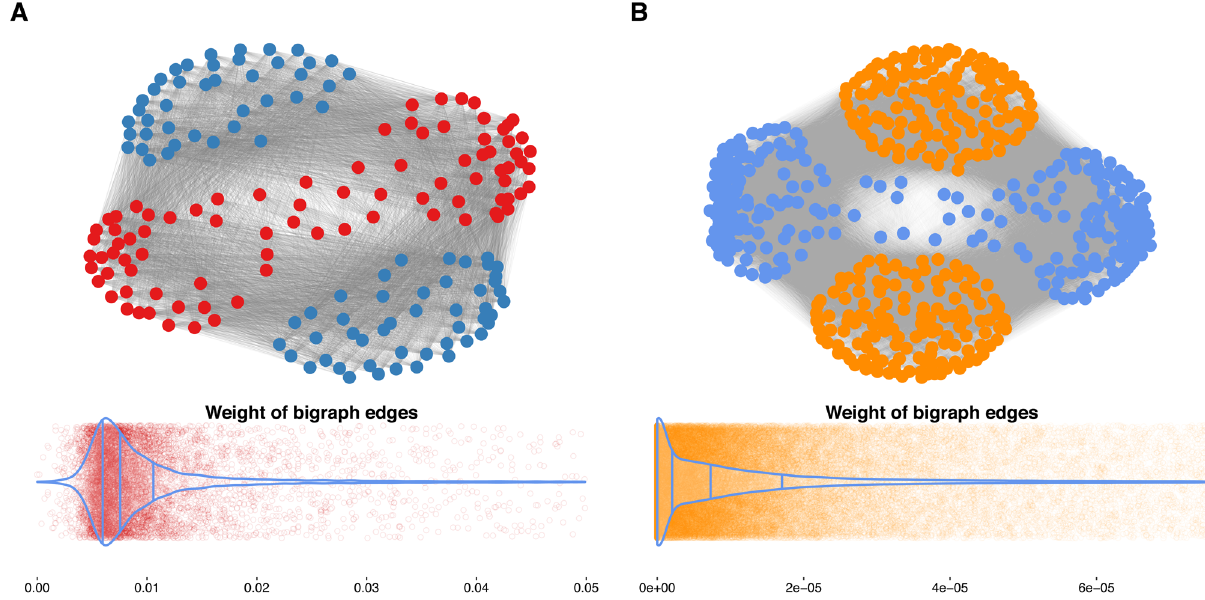
Fig. 3 Bigraphs of cancer datasets. The general overview of the bipartite graphs for the Beat AML ( A ) and GDSC ( B ) datasets is represented with the blue nodes as small molecule inhibitors, and red and orange nodes as patient-derived and cell line samples, respectively. The distributions of edge weight values are also depicted using violin plots together with scatter plots. From left to right, the lines in the violin plots re fl ect the 25th percentile, median, and 75th percentile. The colourful spots on the dim background depict how the original data was distributed. The x-axis represents edge weight, whereas the y-axis shows relative frequency. Source data are provided as a Source Data fi le.